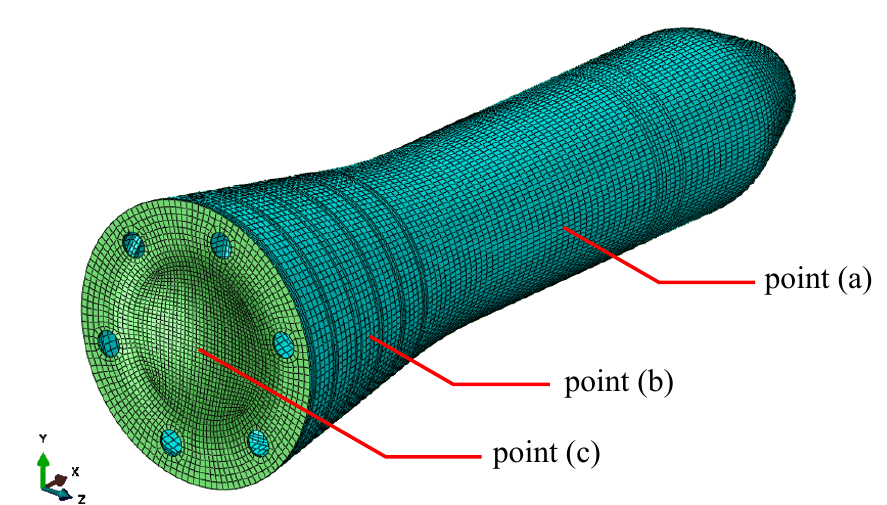
Figure 6. HB–2 Finite Element Model and location of the three points